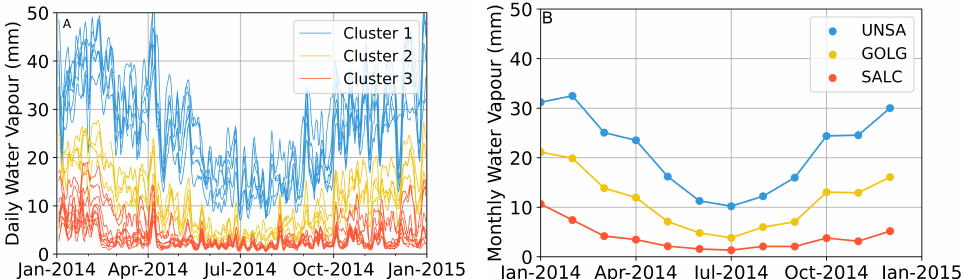
Figure 4. Results of clustering the water vapour readings showing all time series within a cluster with daily temporal resolution ( A ), but station clustering was performed on mean monthly values shown in ( B ). ( B ) shows individual mean monthly values along the topographic gradient exemplified for UNSA at 1224 m, GOLG at 2343 m, and SALC at 3799 m asl station